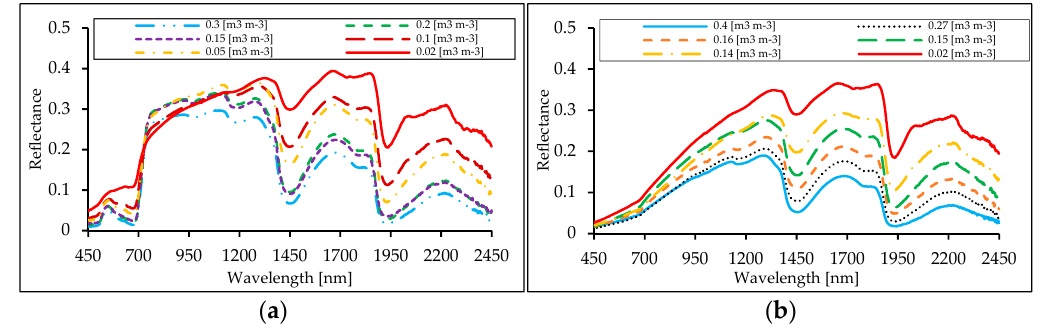
Figure 4. The changes in the shape of reflectance spectra in responses to drought. ( a ) Canopy spectra change at different levels of soil moisture deficit; ( b ) Soil reflectance changes under different soil moisture conditions.